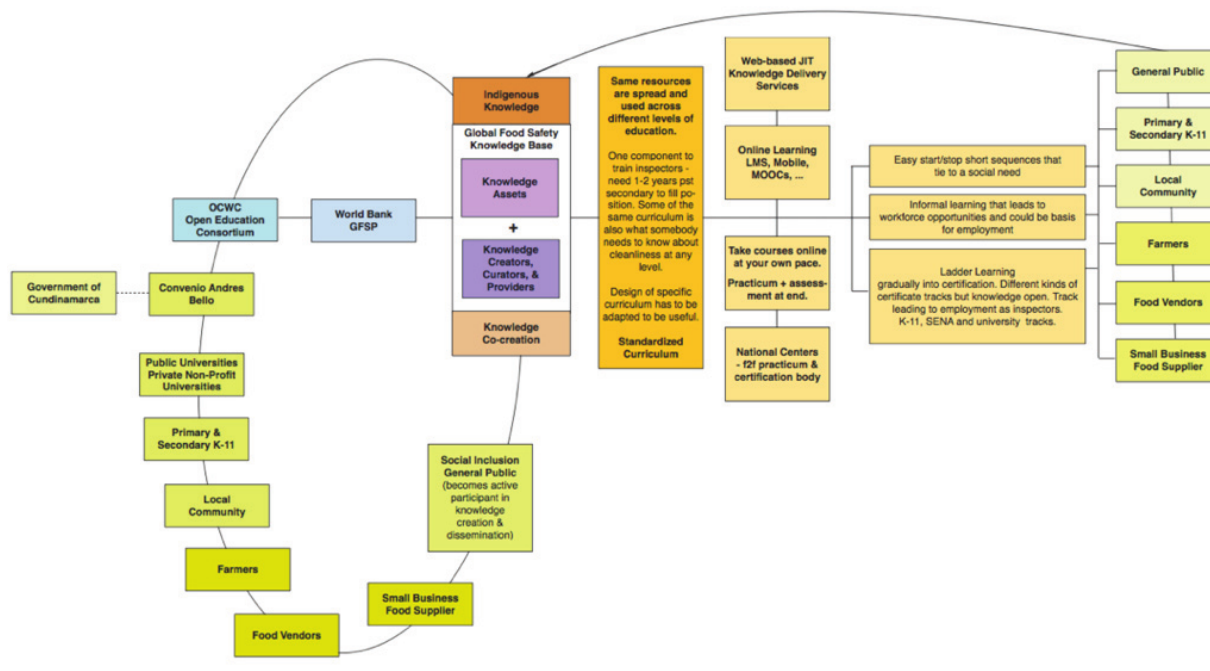
Figure 3. Case example of Colombia. This figure provides an overview of collaborators, resources and approaches being implemented in